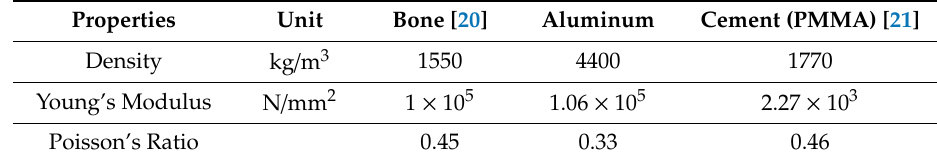
Table 1. Material properties used for computational analysis.